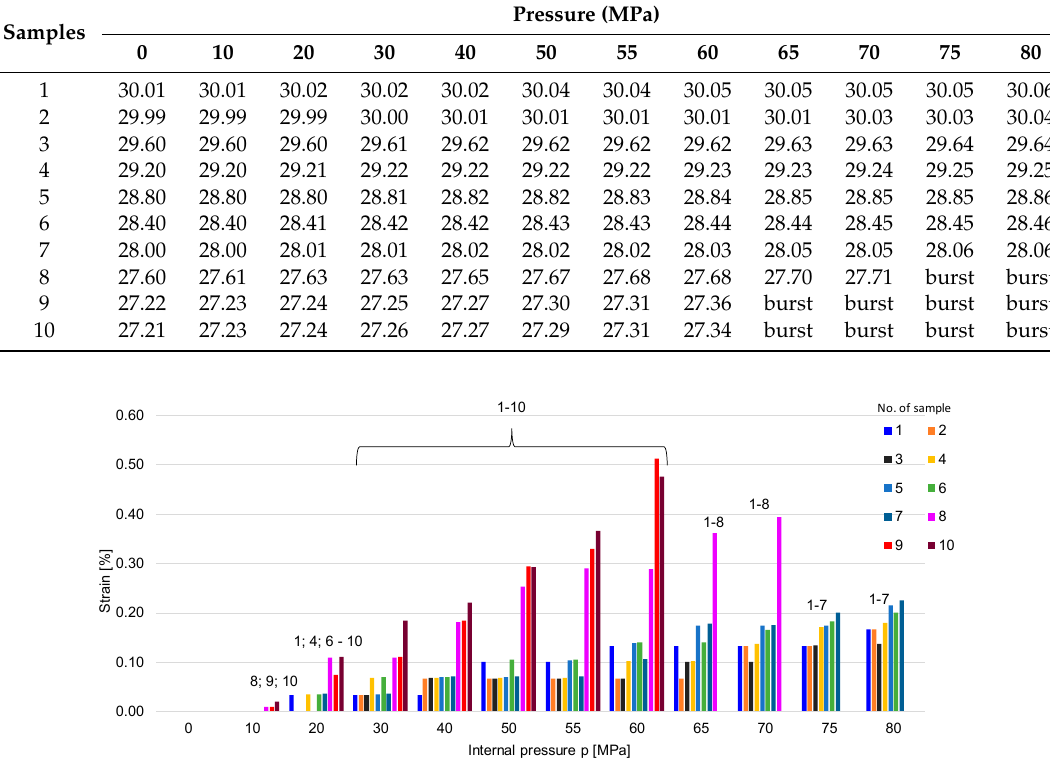
Figure 5. Increasing the exterior diameter of samples with applied internal pressure. The numbers written above the columns represent the numbers of samples which experienced radial strain when pressure was applied.